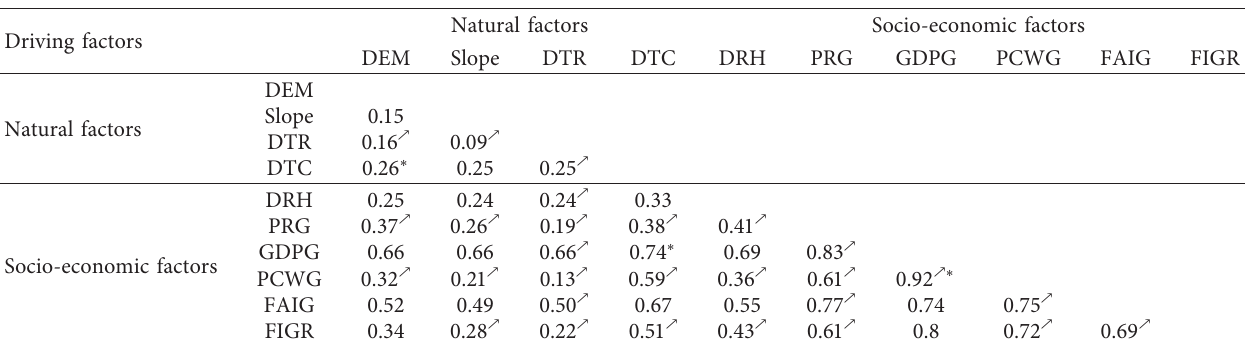
Table 4: Interaction of different factor pairs on urban expansion intensity during 2000–2008.